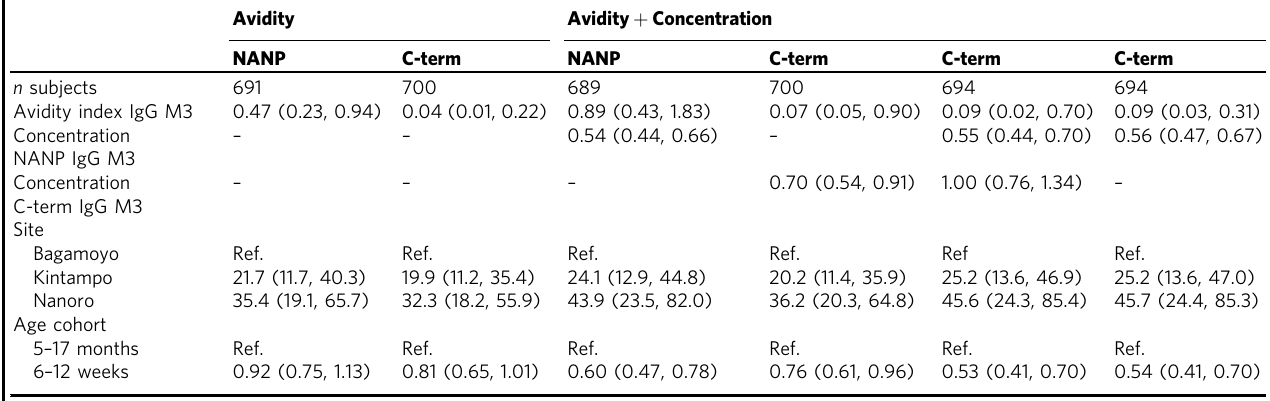
Table 3 IgG antibody avidities to CSP in relation to risk of clinical